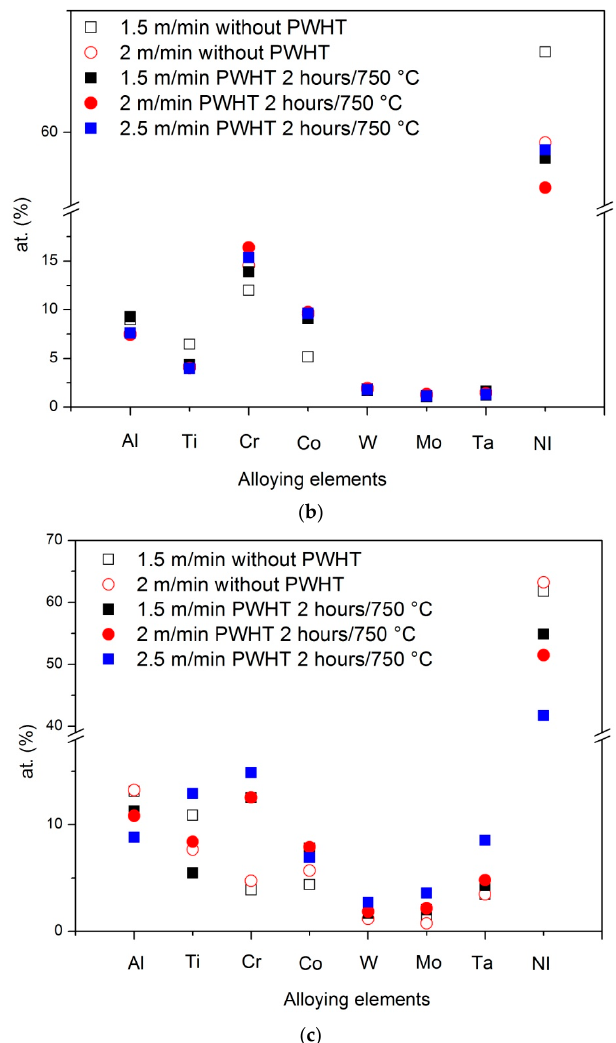
Figure 13. Compositions of γ ’ ( a ) and γ ( b ) phases in HAZ and CS ( c ) in MZ (Tables 4 and 5). After PWHT Ta and W contents of the Chinese script structures increase with increasing welding pass speed. Since carbide size tends to decrease and a more uniform distribution occurs with increasing welding speed the interference of measured carbide compositions by the background is more serious and some composition changes can be attributed to experimental conditions instead of physical processes.